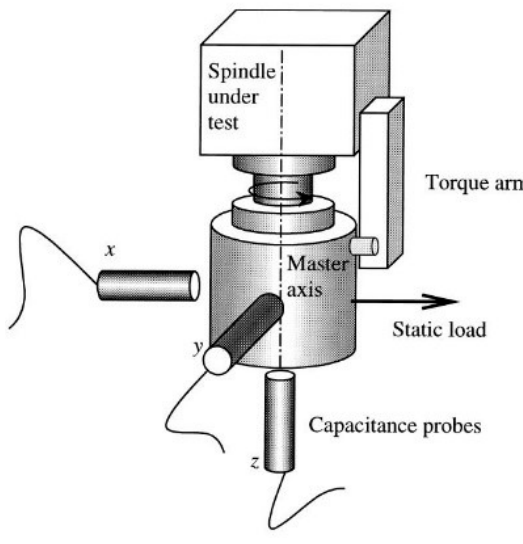
Figure 46. Master axis and its mounting